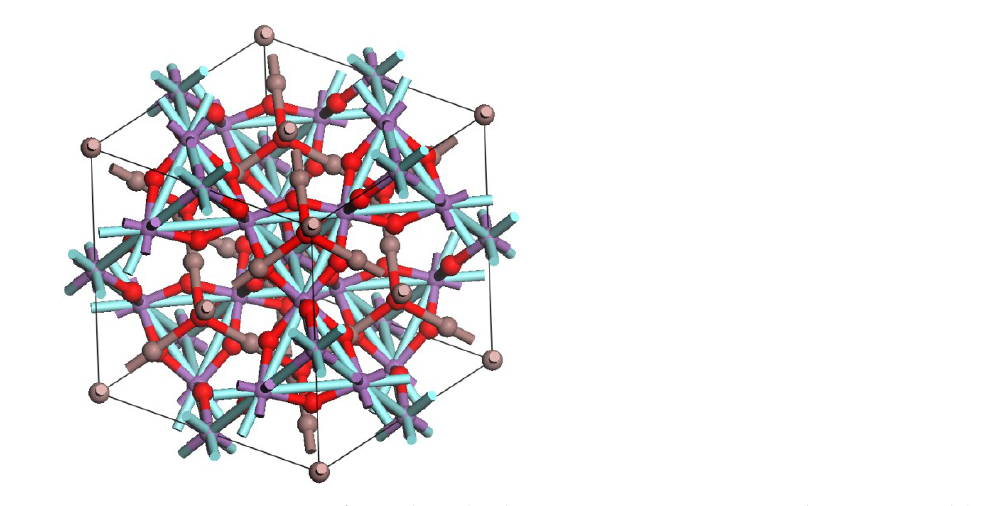
Figure 2. Atomic structure of In 2 YSbO 7 . (Red atom: O; cyan atom: In; purple atom: Y or Sb.). Table 1. Structural parameters of In 2 YSbO 7 synthesized by solvothermal method.